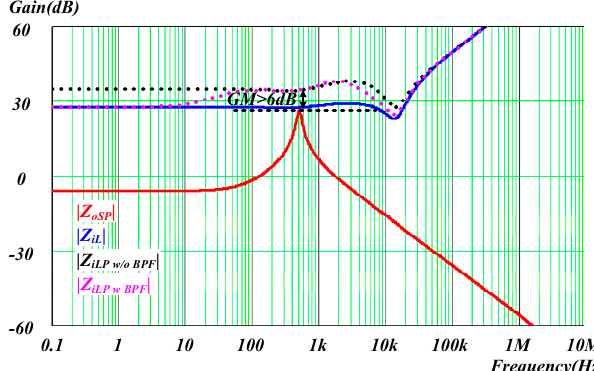
Figure 23. Bode plot of input impedance comparison before and after adding virtual impedance.